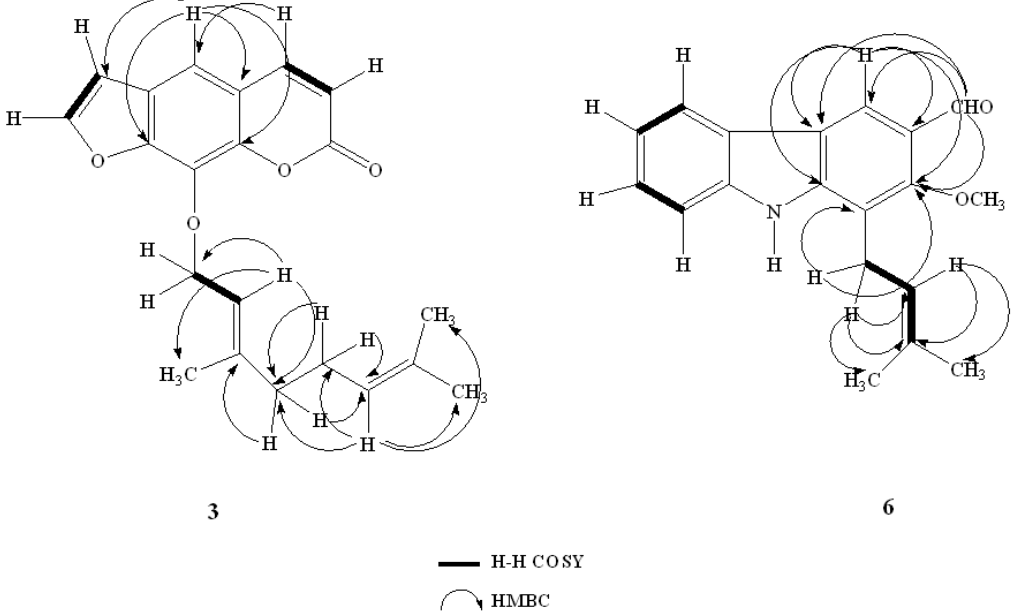
Figure 2. H–H COSY and Key HMBC correlations for compounds 3 and 6